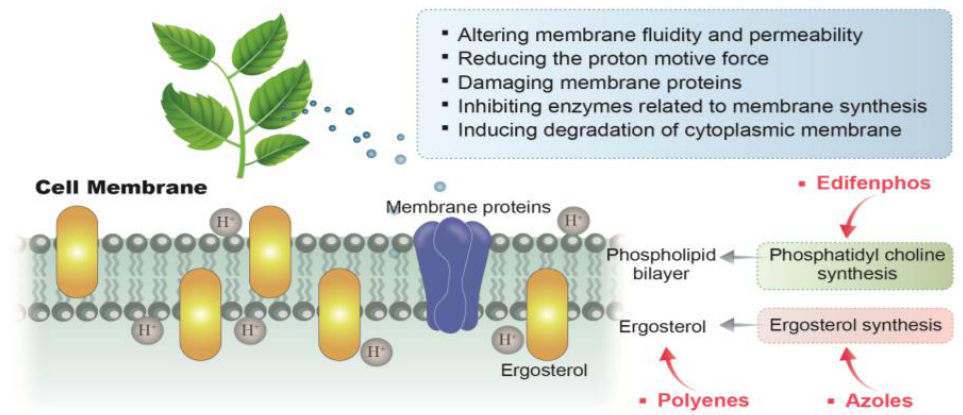
Figure 3. Mechanisms of action of plant-derived natural compounds and antifungal agents acting on the cell membrane of A. flavus .